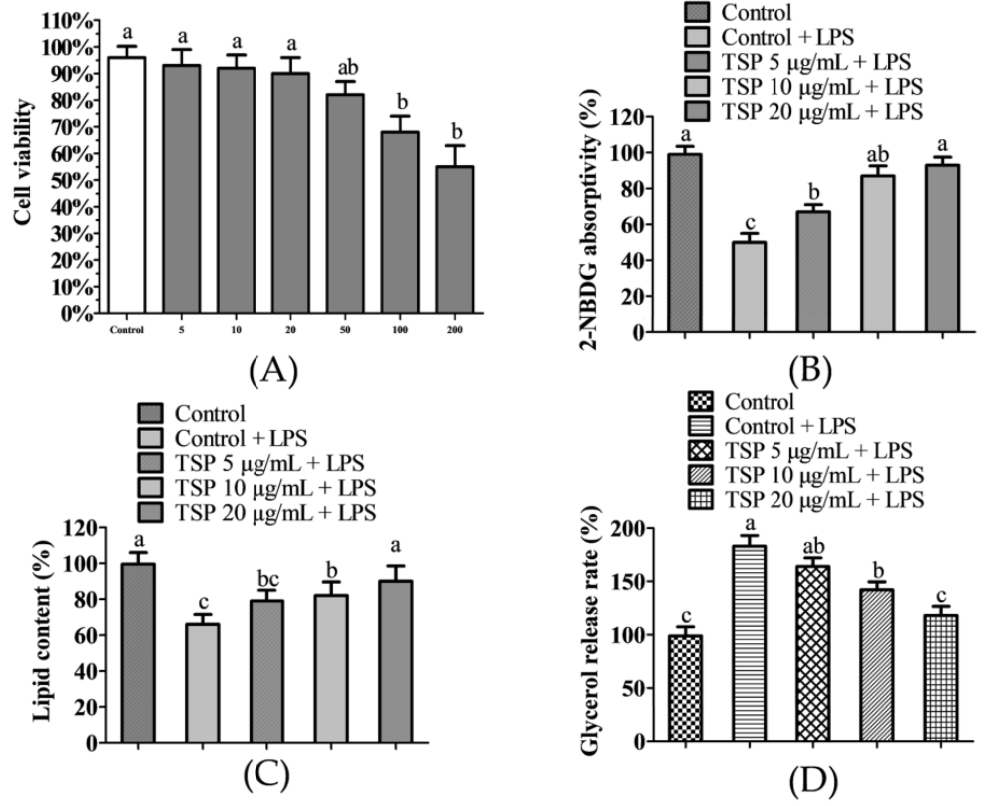
Figure 1. Effects of TSP on the viability of 3T3-L1 cells ( A ), the effect of TSP on glucose uptake levels in 3T3-L1 adipocytes was evaluated using 2-NBDG absorption values ( B ), the effect of TSP on the lipid level of 3T3-L1 adipocytes under inflammatory conditions was evaluated by absorption values ( C ), the effect of TSP on glycerol release from 3T3-L1 adipocytes under inflammatory conditions was evaluated by absorption values ( D ). Data are presented as mean ± SD (n = 3); Results marked with the same letters were not significantly different ( p < 0.05).